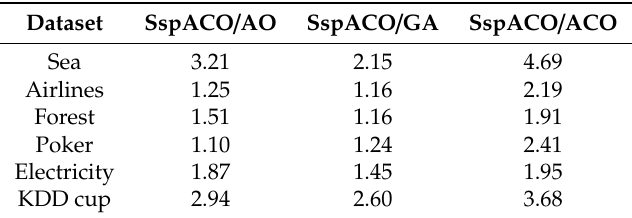
Table 8. Evaluation of Speed Up.